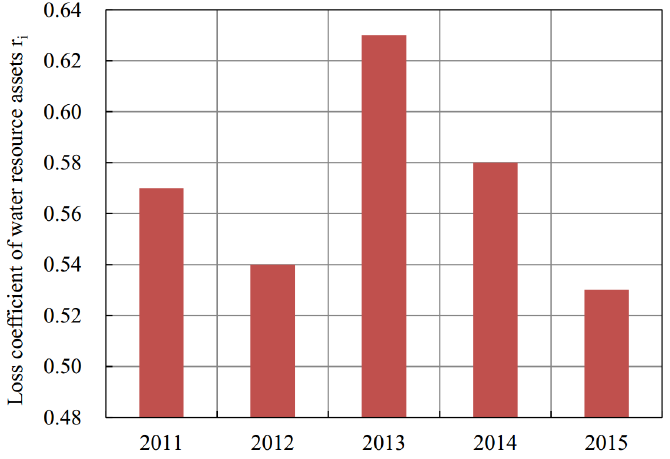
Figure 3. Asset coefficients of water resources for different water